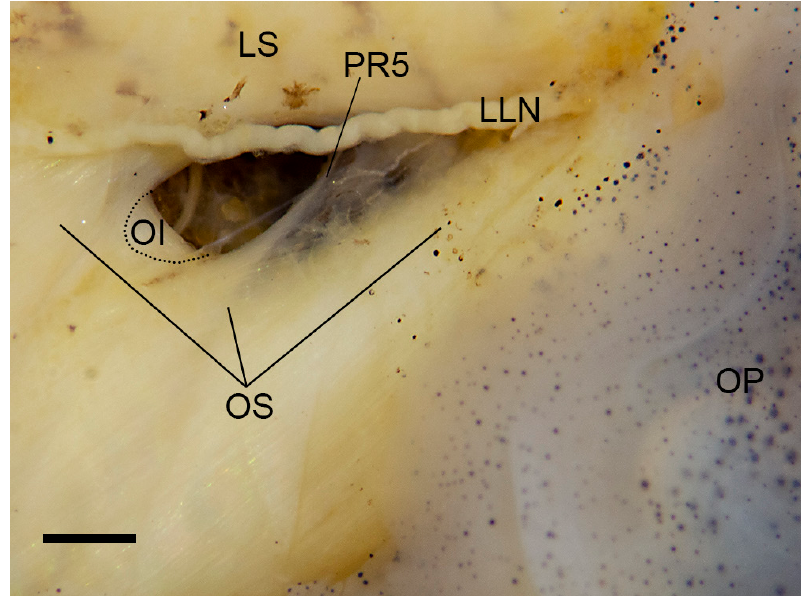
FIGURE 5 | Humeral hiatus in Characidium kalunga , MZUSP 114054, 42.0 mm SL, paratype. Abbreviations: LLN, lateral-line nerve; LS, lateralis superficialis ; OI, obliquus inferioris ; OS, obliquus superioris ; PR5, pleural rib of fifth vertebra. Scale bar = 1